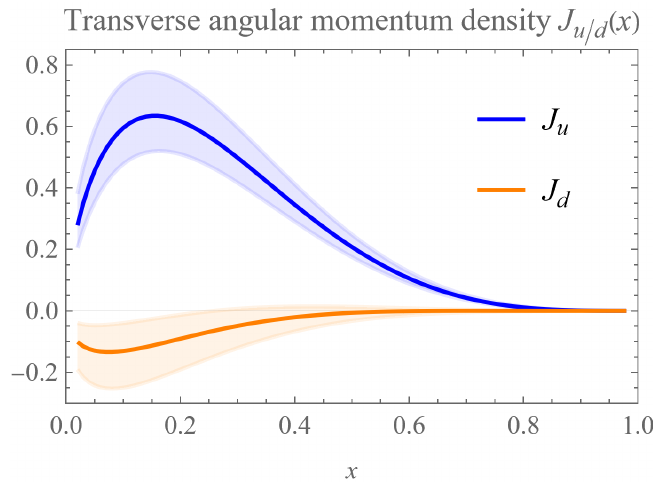
Figure 9 . A plot of the quark transverse angular momentum densities J GPDs H ( x, t ) and E ( x, t ) . Most of the uncertainties are from the GPDs E u/d u/d less constrained without corresponding forward